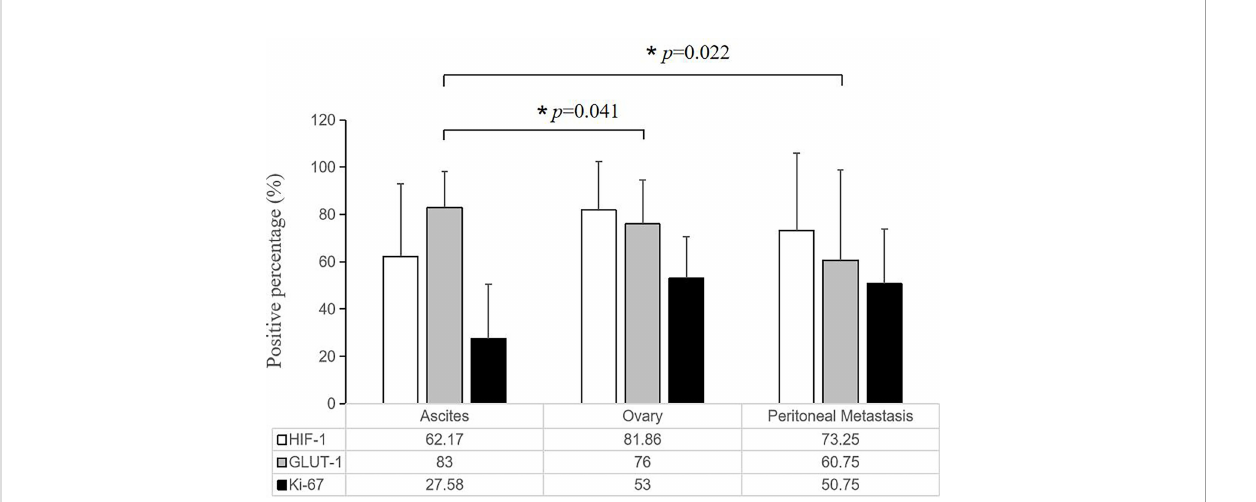
FIGURE 5 Quantitative comparison of the expression of HIF-1 a , GLUT-1 and Ki-67 among tumor cells in the ascites with corresponding primary and peritoneal lesions. There is no signi fi cant difference in the expression of HIF-1 a and GLUT-1, but the ascites tumor cells had a relatively low Ki- 67 expression level compared with their corresponding primary and solid metastatic lesions (* P < 0.05, the error bars was standard deviation.).